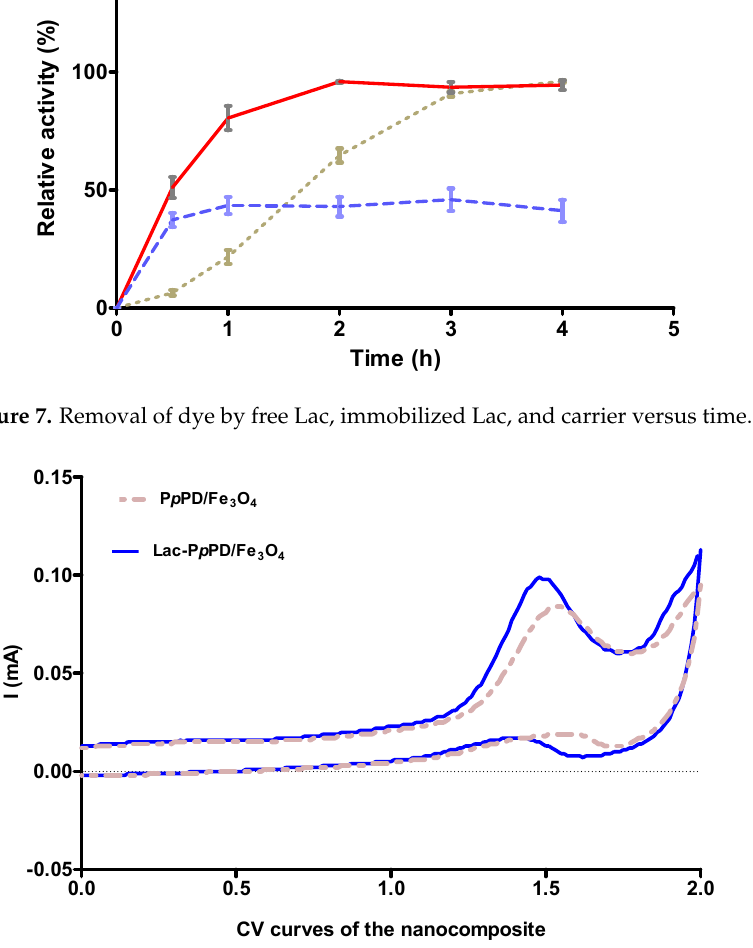
Figure 8. Cyclic voltammetry curves of the P p PD/Fe 3 O 4 and Lac-P p PD/Fe 3 O 4 nanocomposites.